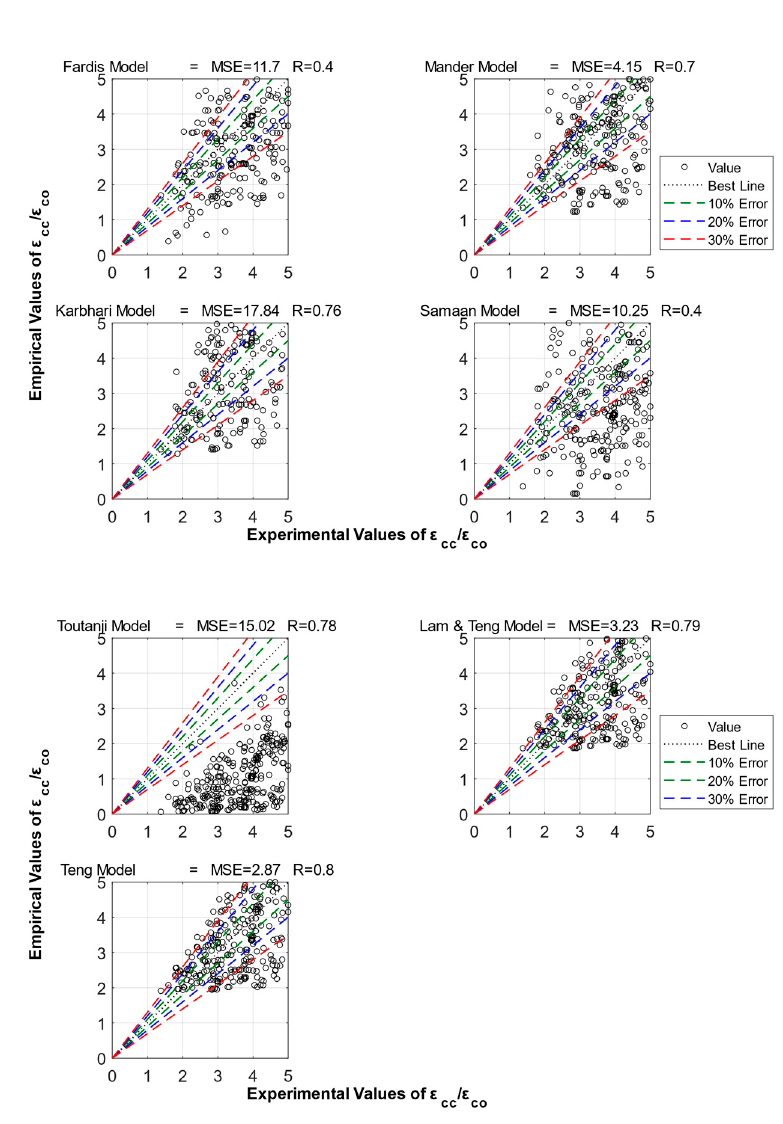
Figure 8. Performance of previously proposed strain models of confined concrete on the developed database.